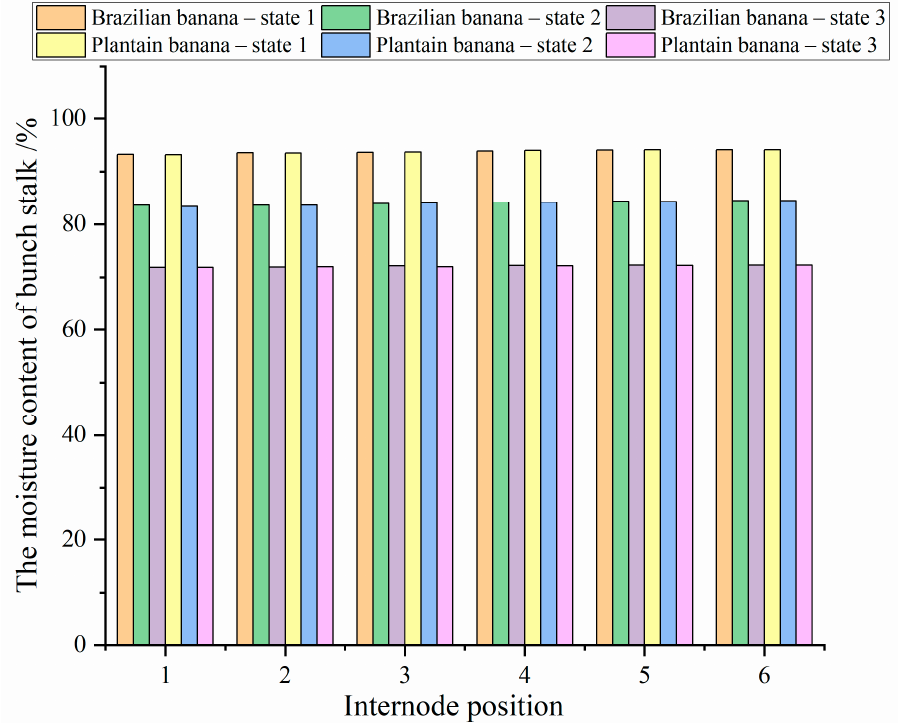
Figure 12. The relationship between the moisture content of bunch stalks and the internode posi- tions.